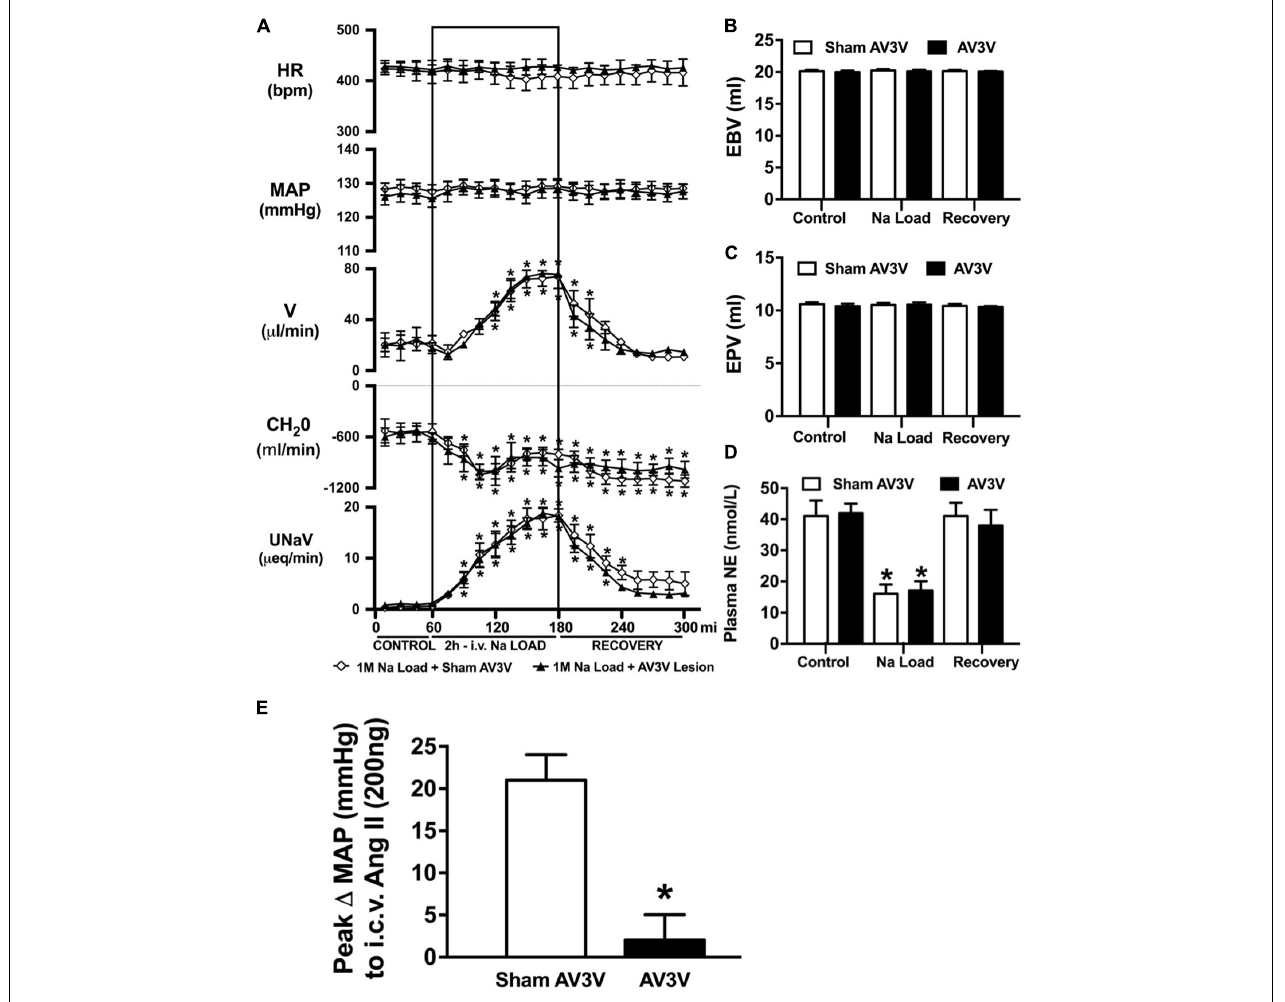
FIGURE 2 | Effect of an AV3V lesion on the cardiovascular and renal responses to an acute 1M NaCl infusion (A) Cardiovascular and renal responses, (B) Estimated blood volume (ml), (C) Estimated plasma volume (ml), and (D) Plasma norepinephrine content (nmol/L) during a 1-h control isotonic saline infusion (20 µ l/min), a 2-h 1M NaCl infusion (20 µ l/min) and a 2-h recovery period of isotonic saline infusion (20 µ l/min) in sham or AV3V lesioned conscious male Sprague Dawley rats, and (E) peak (cid:49) MAP following an i.c.v. bolus injection of Ang II (200 ng) N = 4/group for Ang II administration. HR = heart rate (bpm), MAP = mean arterial pressure (mmHg), V = urinary flow rate ( µ L/min), CH 2 O = free water clearance, UNaV = urinary sodium excretion ( µ eq/min). Data are presented as mean ± SEM, N = 8/group except where indicated. * p < 0.05 vs. group baseline value in last 15-min of the control saline